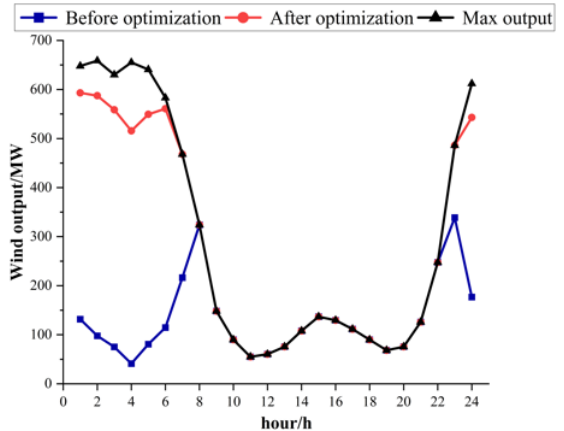
Figure 11. The total power/gas demand before and after the optimization in Scenario 2.